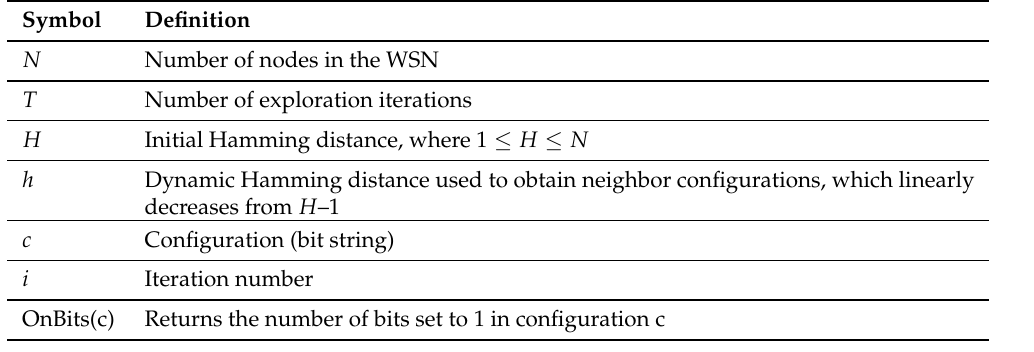
Table 1. Algorithm definitions.